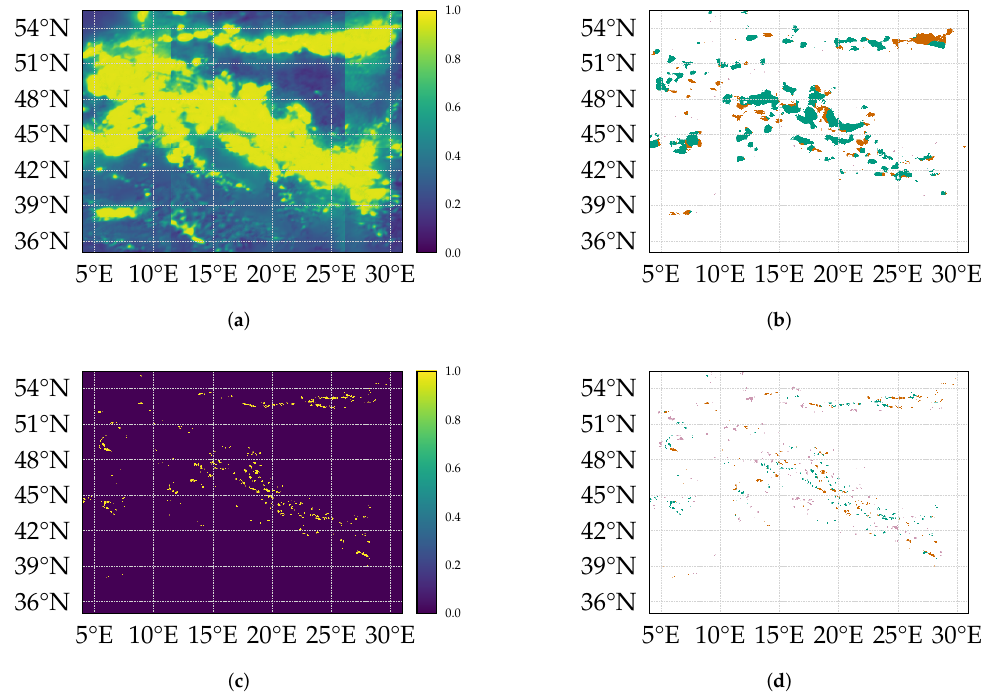
Figure 5. Predictions and skill of the compared methods for a 120 min forecast during a severe weather event, 4. June 2016 12:00 UTC. ( a ): Unscaled model logits. Sharp lines at around 11°E, 26°E and 43°N are artifacts from the domain decomposition scheme, detailed in Appendix A.3. ( b ): Model skill: CSI 77.82%, POD 78.25%, FAR 21.74%. ( c ): Persistence predictions. Cbs remain static, no forecast is applied. ( d ): Persistence skill: CSI 43.46%, POD 60.86%, FAR 39.13%. True positives are marked green, false positives orange, and false negatives